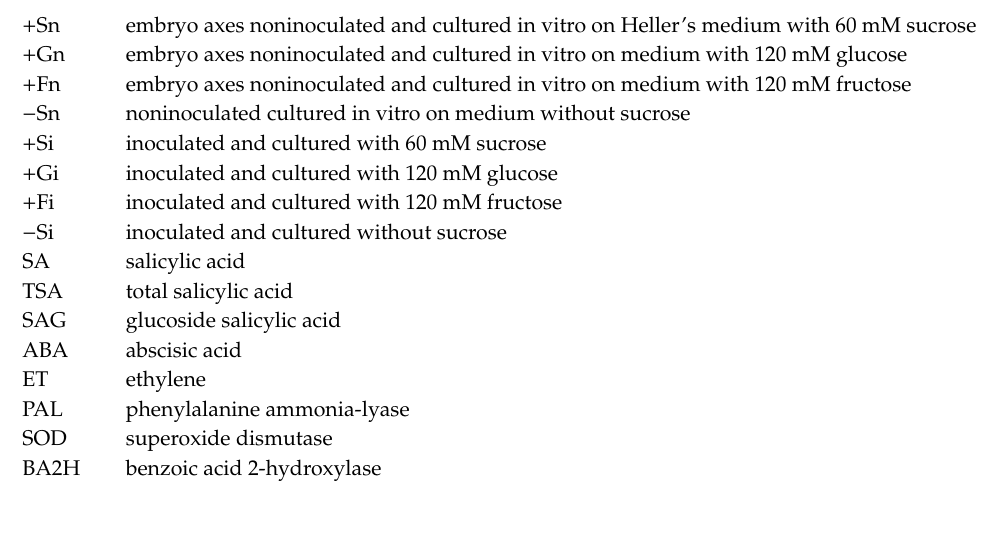
t-test for hydrogen peroxide content, Table S7. Statistical significance of di ff erences between the average values Table S9. Statistical significance of di ff erences between the average values of each pairs and Student’s t-test for superoxide dismutase